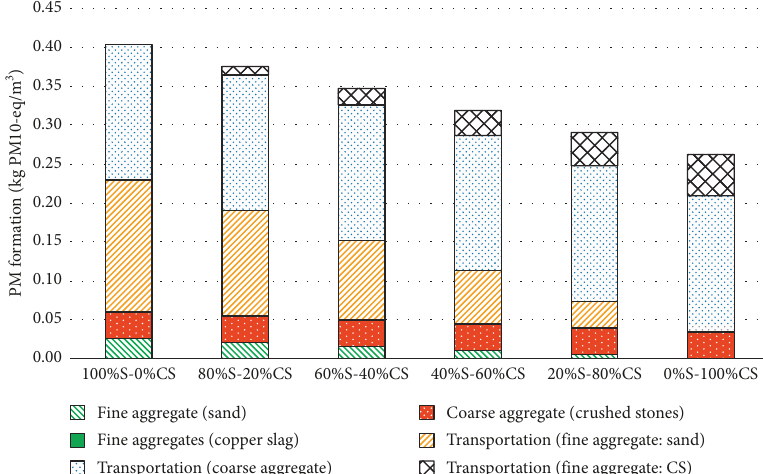
Figure 8: Distribution of PM formation results for concrete aggregates (cement impacts are excluded), GreenConcrete LCA tool [3].